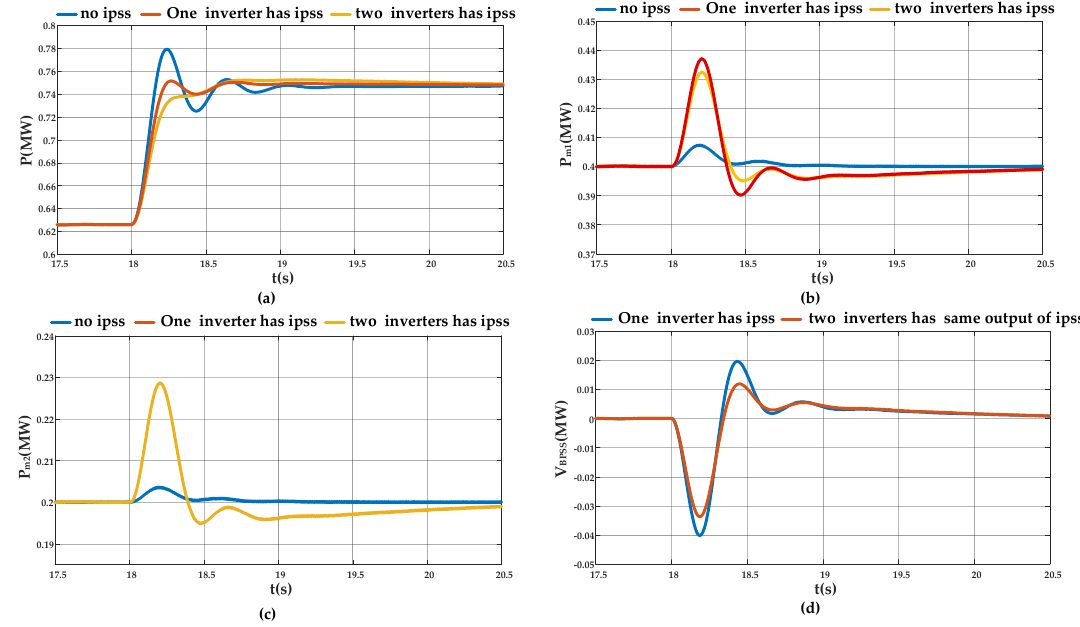
Figure 11. Simulation results of two parallel grid-connected inverters system with different built-in PSS situations, case I: none of the inverters has built-in PSS; case II: only the larger output inverter has built-in PSS; case III: both of the inverters have built-in PSS. ( a ) Active power fluctuation comparison of generator under the three cases; ( b ) active power of the larger output inverter under the three cases; ( c ) active power of the lower output inverter under the three cases; ( d ) output of built-in PSS in the inverters under the three cases.